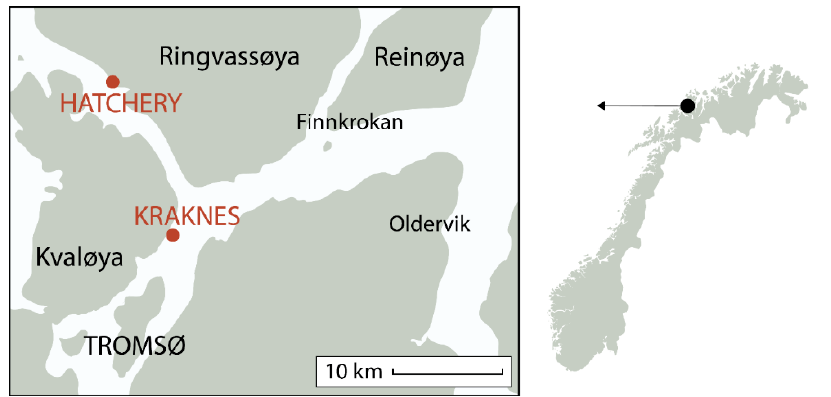
Figure 1. Map of hatchery and cultivation site (Kraknes).